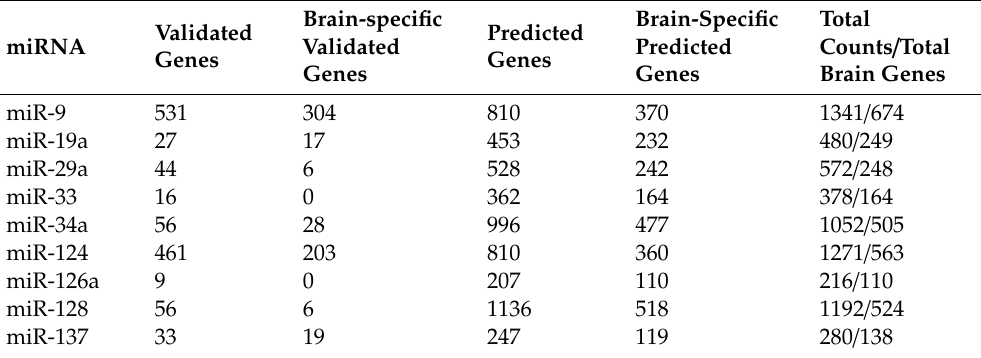
Table 2. Counts of validated and predicted target genes for each miRNA.